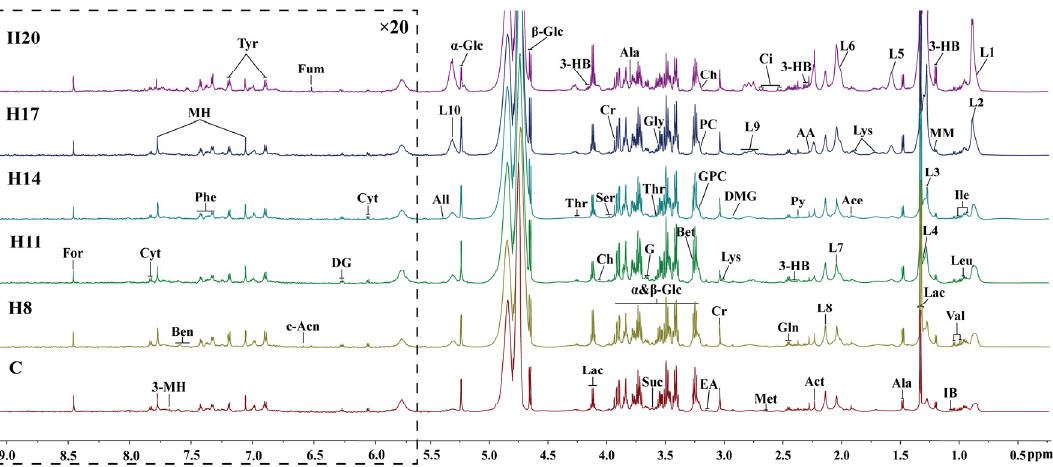
Figure 1. 600 MHz 1 H NMR spectra ( δ 0.5–9.0) of serum’s samples obtained from C group, and H group at different periods (D8, D11, D14, D17, and D20). The spectra in the region δ 5.5–9.5 were magnified 20 times compared with the region δ 0.5–5.5 for the purpose of clarity. Ala,